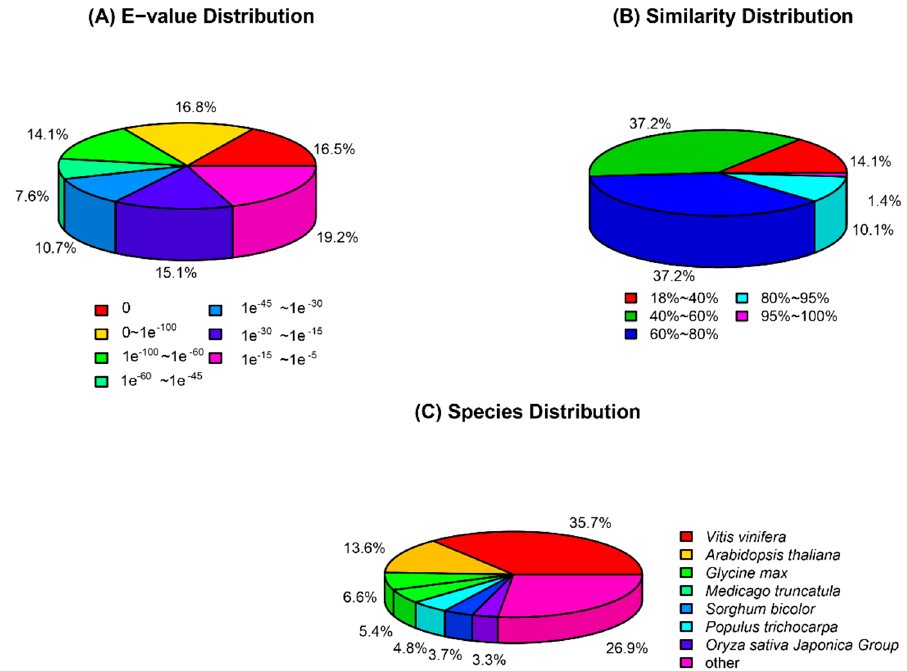
Figure 1. Species statistics and distribution of unigenes in F. tataricum transcriptome. ( A ) The E-value frequency distribution of Nr annotated unigenes using E-value frequency distribution analysis; ( B ) Sequence similarity distribution of the Blast hits for each unigenes; ( C ) The species homologous distribution analysis. It is shown as the percentage of the total homologous sequences in the Genebank non redundant (Nr) database.